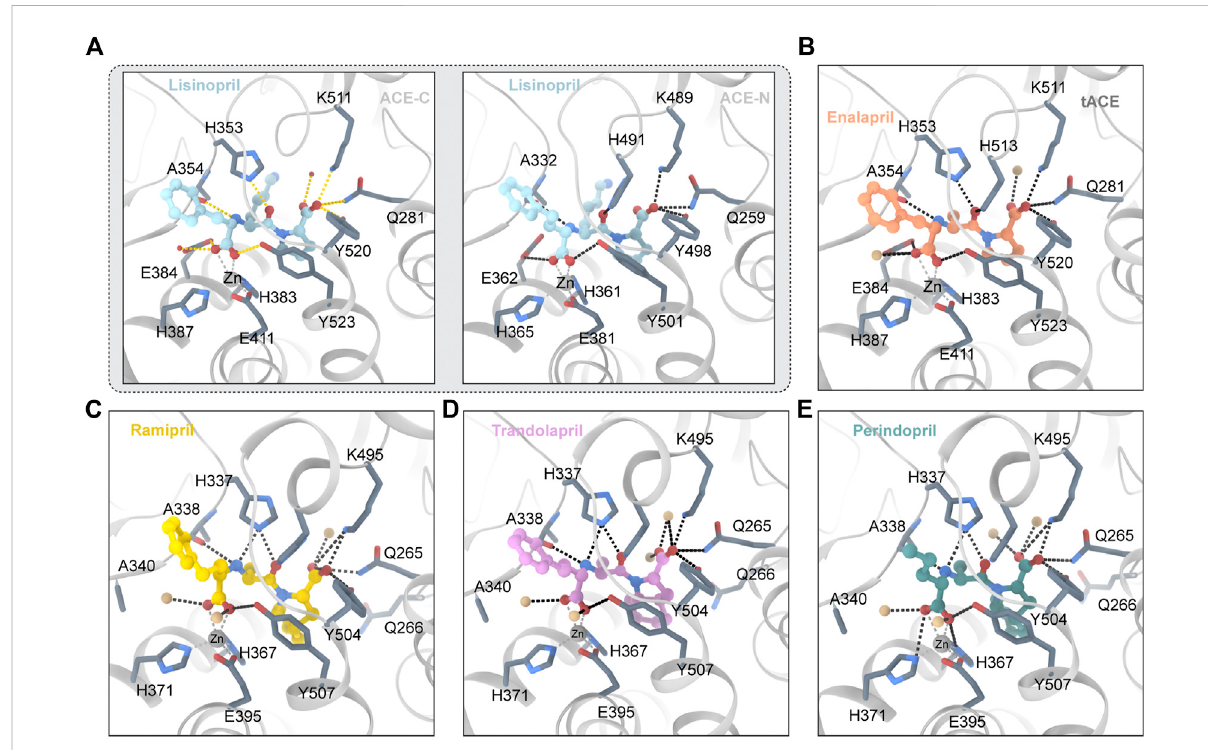
FIGURE 2 (A) Lisinopriland ACE(PDB ID:1O86 2C6N) Criticalresiduesareidenti fi edusingaone-lettercode.Theligandmoleculeisshown inbluebyballs andsticksHydrogenbondsarerepresentedbydashedlines. (B) EnalaprilandACE(PDBID:1UZE)Theligandmoleculeisshowninorangebyballsand sticks. (C) Ramipril and ACE (PDB ID:2X92) The ligand molecule is shown in yellow by balls and sticks. (D) Trandolapril and ACE (PDB ID:2X93) The ligand molecule is shown in pink by balls and sticks. (E) Perindopril and ACE (PDB ID:2X94) The ligand molecule is shown in green by balls and